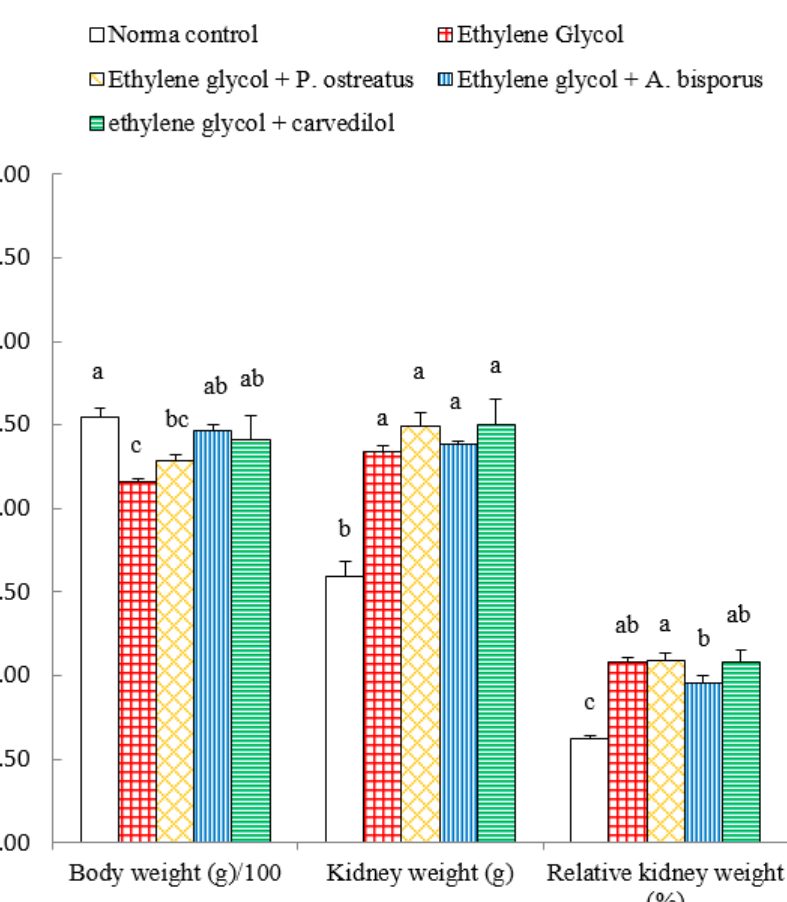
Figure 3 . GC-MS analysis of A. bisporus aqueous extract . Figure 3. GC-MS analysis of A. bisporus aqueous extract.